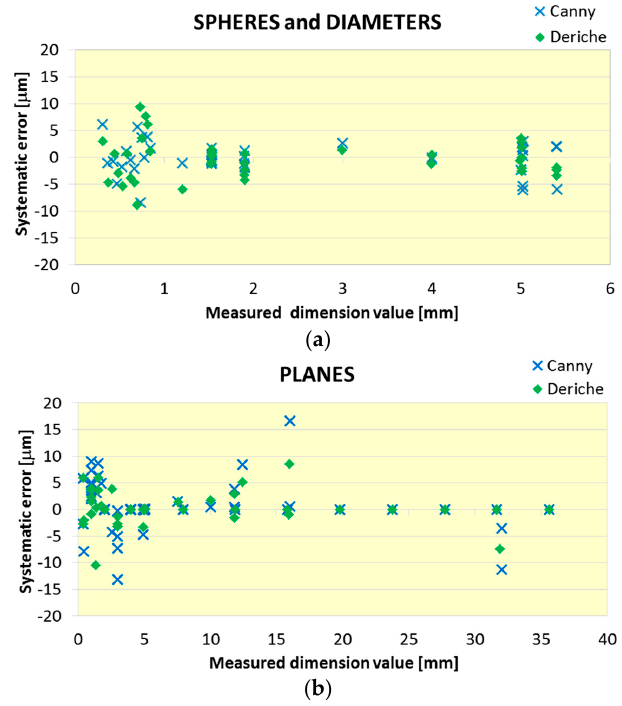
Figure 13. Systematic error source contribution analysis ( u b2 ) by method and by dimension type for ( a ) spheres and diameters and ( b ) planes.